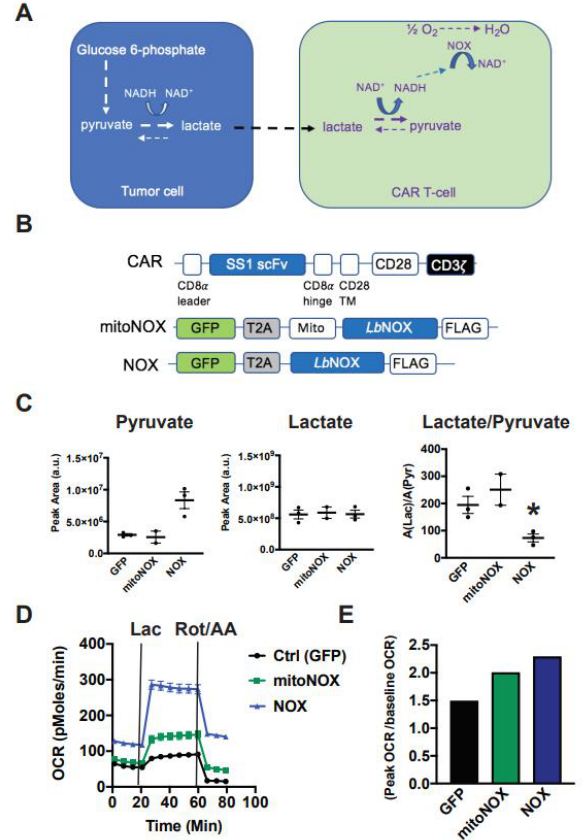
Figure 2. Cytoplasmic Lactobacillus brevis NADH Oxidase ( LbNOX ) reprograms T-cell metabolism towards lactate oxidation. ( A ) Our model proposing how LbNOX promotes lactate metabolism in CAR T-cells. Using NADH as a cofactor, LbNOX drives the vectorial flux of lactate to pyruvate in CAR T-cells. ( B ) Schematic representation of the mesothelin lentiviral CAR containing an SS1 single chain variable fragment (scFv), which is linked via a CD8 α hinge, as well as a CD28 TM to the CD28 and CD3 ζ intracellular signaling domains. TM, transmembrane. LbNOX is a bicistronic lentiviral construct containing the coding sequence for LbNOX , linked via T2A to the transduction marker GFP. A lentiviral construct encoding the mitochondrial (mito) NOX isoform is also shown. ( C ) After overnight stimulation with Dynabeads, activated T-cells were infected with either cytoplasmic or mito LbNOX lentivirus. Cellular supernatants were collected from NOX-expressing T-cells undergoing log-phase expansion. Lactate, as well as pyruvate levels, was compared by LC-MS. Mean values ± S.E.M are plotted with the horizontal bars representing the mean and each symbol representing a separate donor from independent experiments. The lactate/pyruvate ratio was significantly decreased in LbNOX relative to GFP (* p < 0.05). Statistical comparisons were performed using an unpaired Student’s t test. ( D ) After overnight stimulation with Dynabeads, activated T-cells were infected with either cytoplasmic or mito LbNOX lentiviral supernatants. These cells were expanded for 3 days and then transferred to bicarbonate-free XF assay medium. Metabolic parameters were measured by a Seahorse assay. Cellular oxygen consumption rates (OCR) were measured at baseline and following the serial addition of 20 mM lactate and 500 nM rotenone/antimycin A. Values are means ± S.E.M. from 7–8 replicates. Values are representative of 2 independent experiments. Baseline OCR levels were significantly increased in mitoNOX relative to GFP ( p < 0.05); LbNOX relative to GFP ( p < 0.05); and LbNOX relative to mitoNOX ( p < 0.05). Lactate-stimulated OCR levels were significantly increased in mitoNOX relative to GFP ( p < 0.05); LbNOX relative to GFP ( p < 0.05); and LbNOX relative to mitoNOX ( p < 0.05). Data were analyzed by a one-way ANOVA using a Holm–Sidak multiple comparison post hoc test. ( E ) Energy reserve (peak OCR/baseline OCR) as a function of LbNOX is shown. Values are calculated from the data illustrated in panel